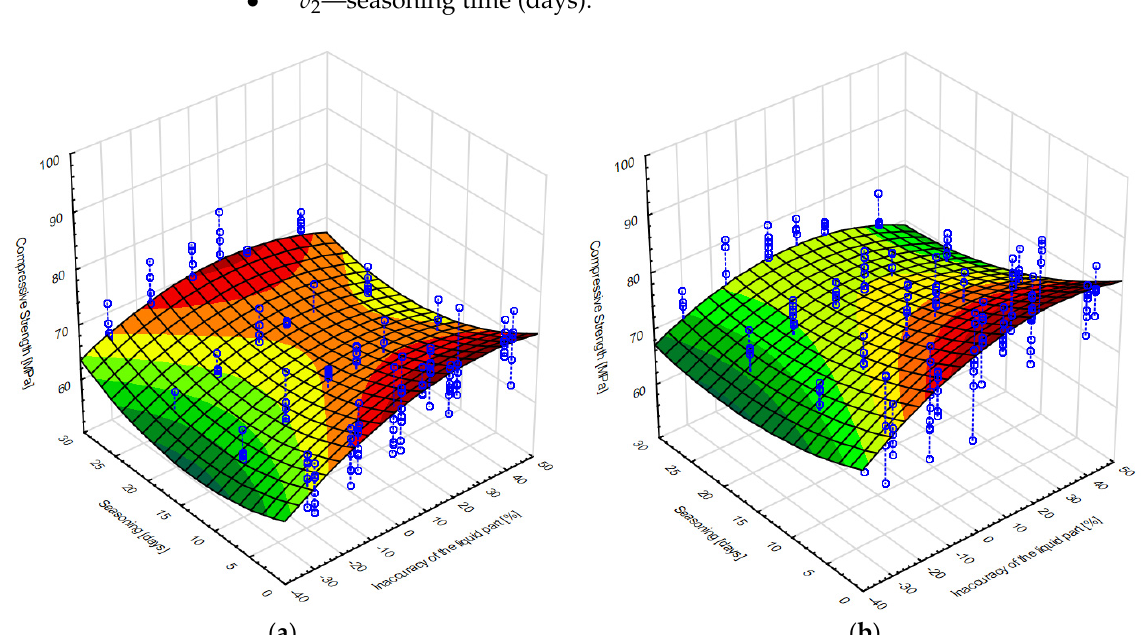
Figure 6. Surface model of compressive strength from liquid component inaccuracy and seasoning time for: ( a ) Palamed, ( b ) CMW3 Gentamicin.